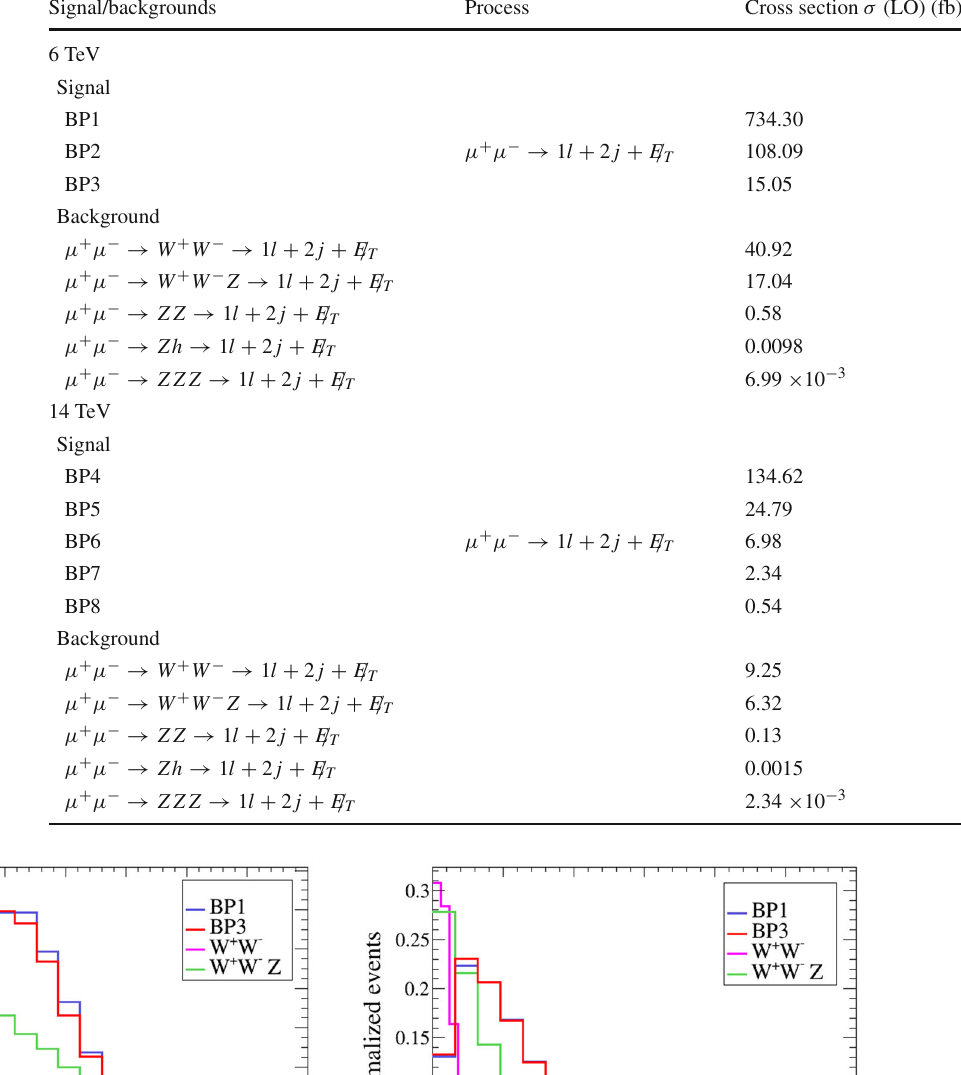
Table 6 The LO cross sections for signal and backgrounds for the process μ + μ − → 1 l + 2 j + E